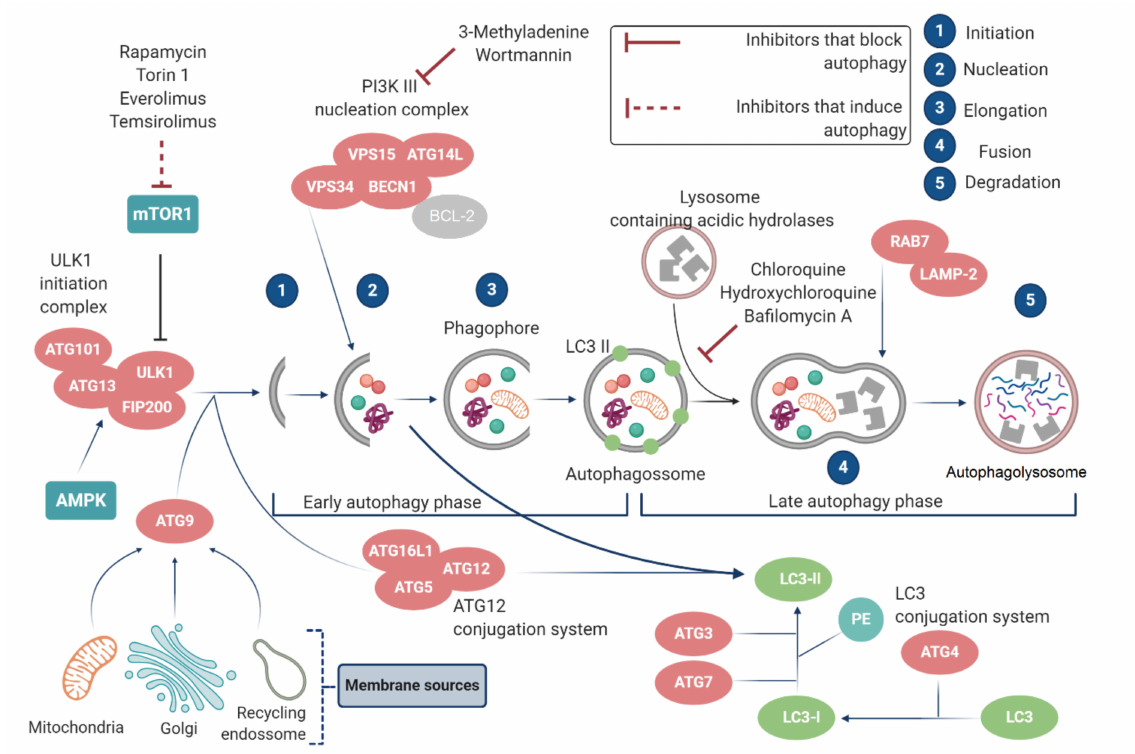
Figure 3. Steps of